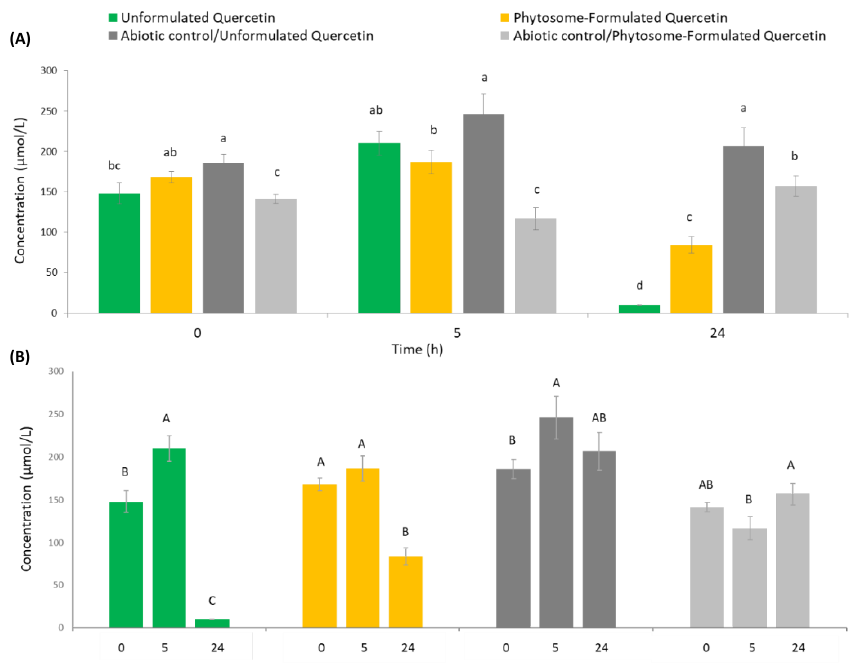
Figure 1. Concentration (µmol/L) of native quercetin in unformulated and phytosome-formulated products and abiotic controls (containing the growth medium and the product aqueous suspension, without fecal slurry) at different time point (0 h, 5 h, and 24 h). Data are expressed as means ± SD ( n = 3). ( A ) Different lower case letters indicate significant differences among fermented samples considering the same incubation period ( p < 0.05). ( B ). Different upper case letters indicate significant differences considering the same fermented sample at different incubation periods ( p < 0.05).